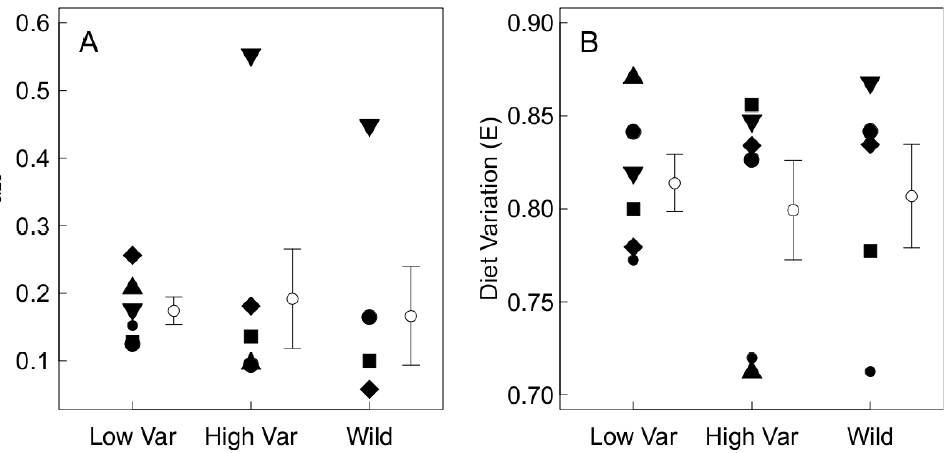
Figure 4. Effect of stickleback size variance on population-level diet variation. a) variance in mean prey size among individuals (BIC size ) and b) mean pairwise diet dissimilarity based on prey frequency data (E). Symbols correspond to spatial blocks, and O`wildO´ samples correspond to fish caught outside five of the six blocks. Mean + 1 SE. doi:10.1371/journal.pone.0020782.g004 PLoS ONE |